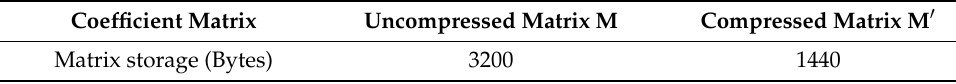
Table 1. Comparison of the coefficient matrix storage.